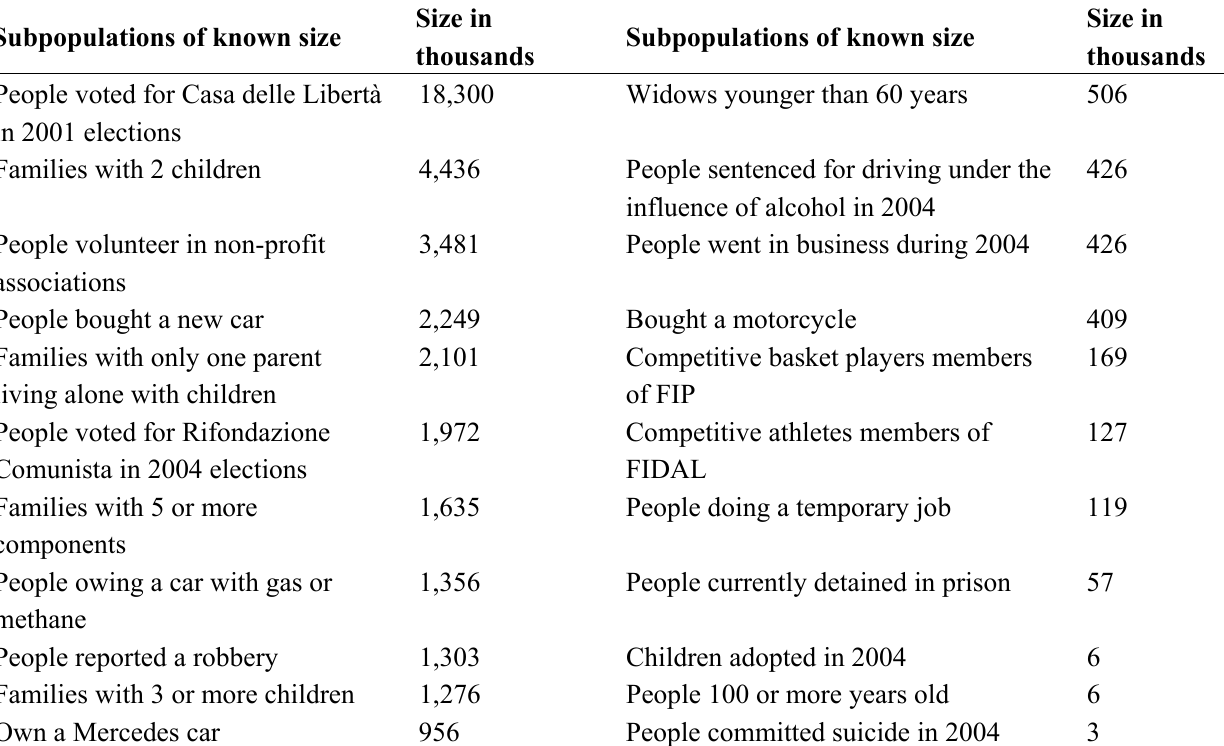
Table 1. Subpopulation of known size used to estimate the respondents’ social network